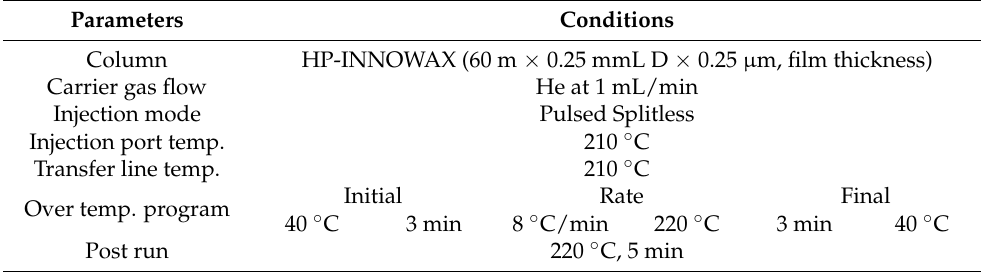
Table 2. The conditions for the operating parameters for